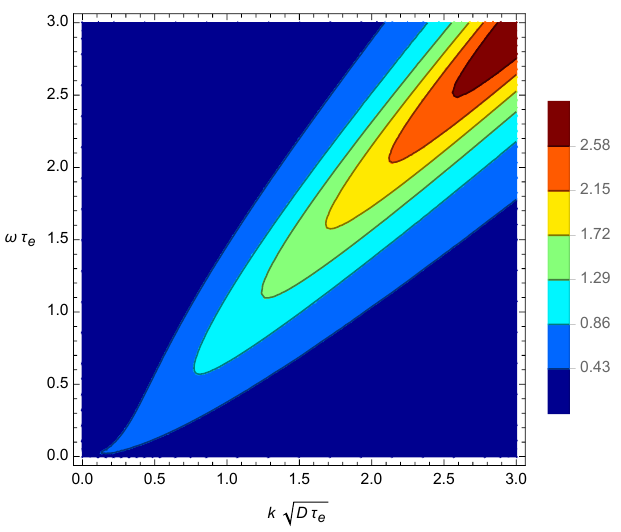
( ω , k ) from (25) as a function of dimensionless nn